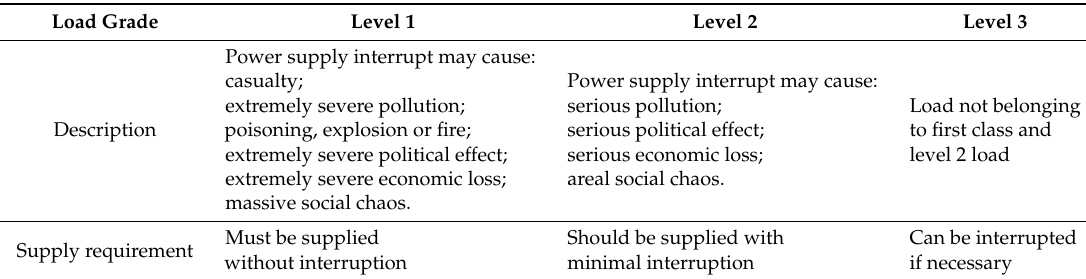
Table 2. Classification of load based on their importance.